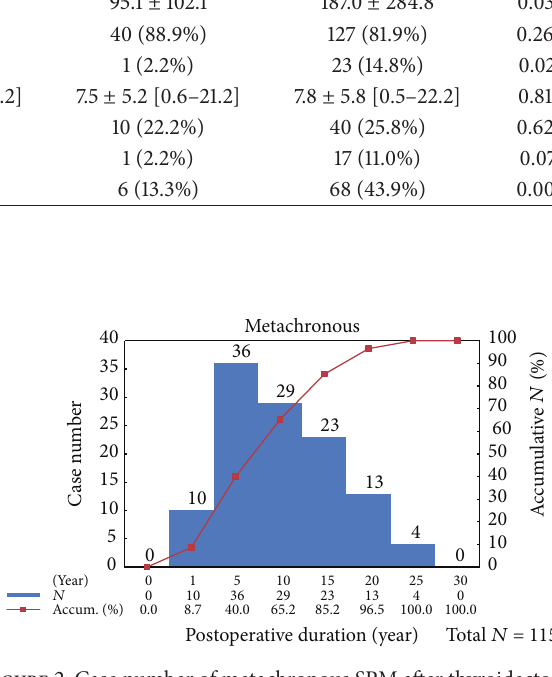
Figure 2: Case number of metachronous SPM after